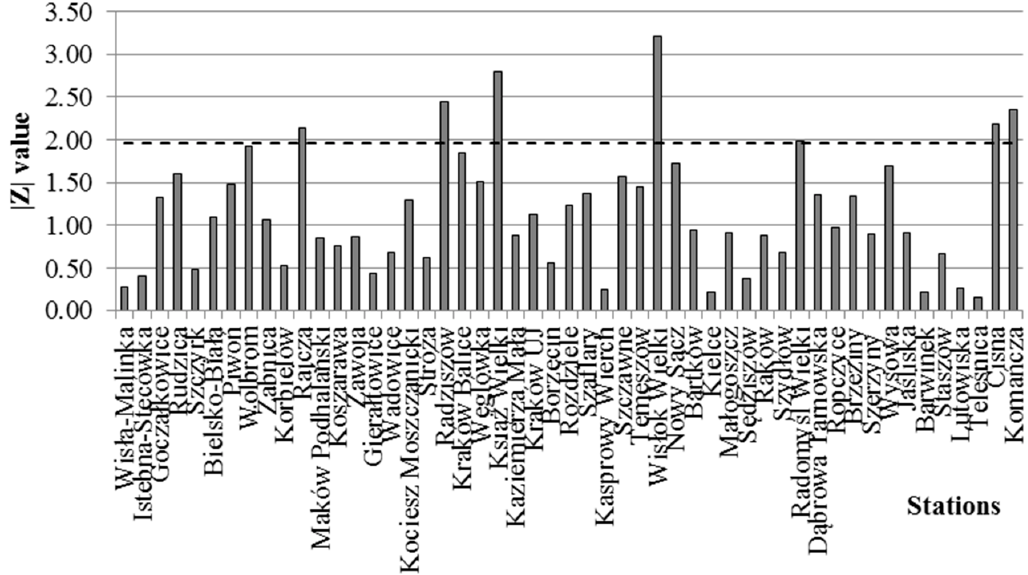
Figure 2. Results of the Z statistics for the Mann-Kendall test.